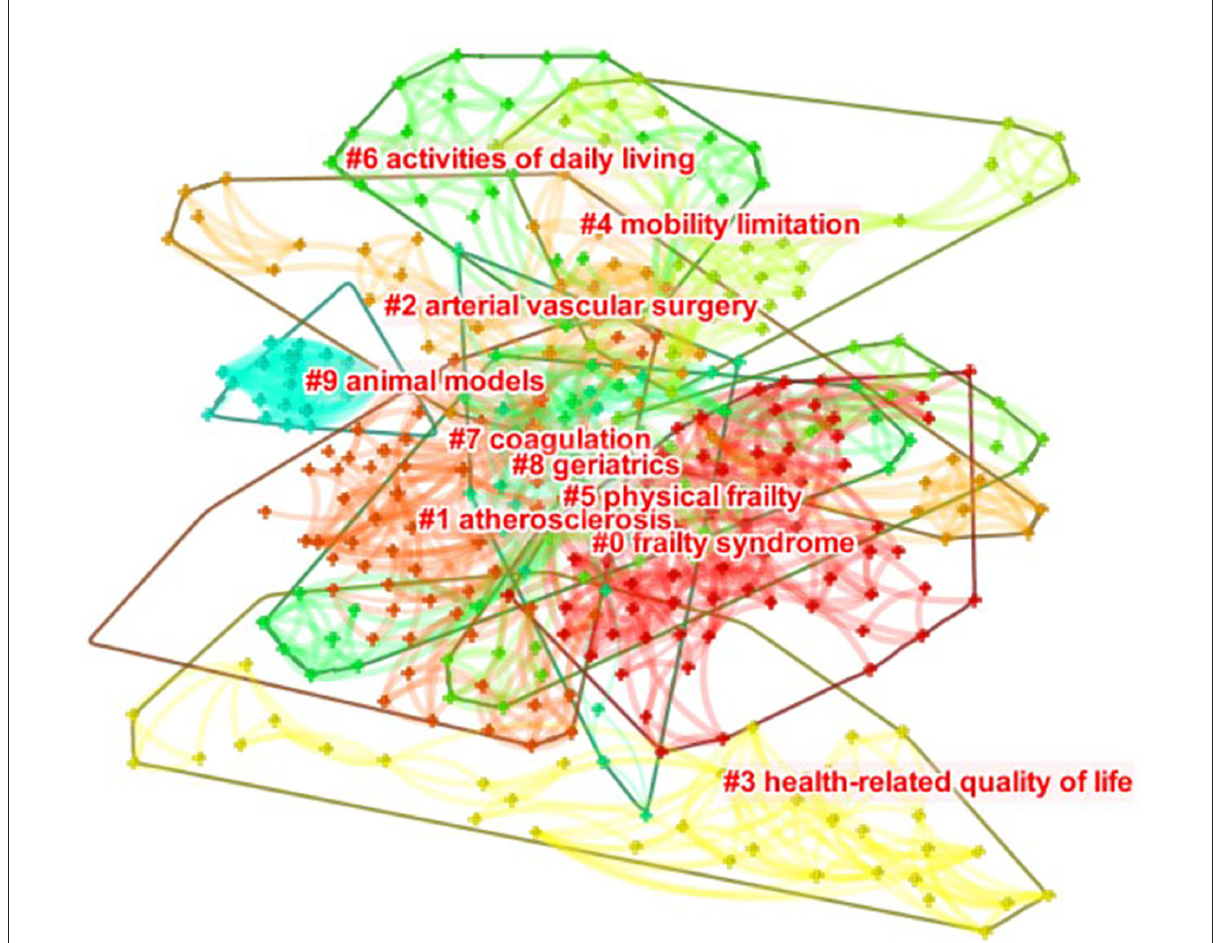
FIGURE7 Clusters of keywords related to CVD with frailty from 2000 to